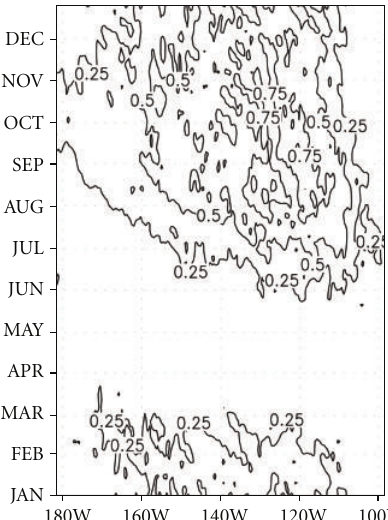
Figure 9: Longitude-time distribution of the climatological cycle of temperature advection by TIWs averaged between 4 ◦ S and 4 ◦ N from the surface to a depth of 50 m. Units are ◦ C/month. Space smoothing was